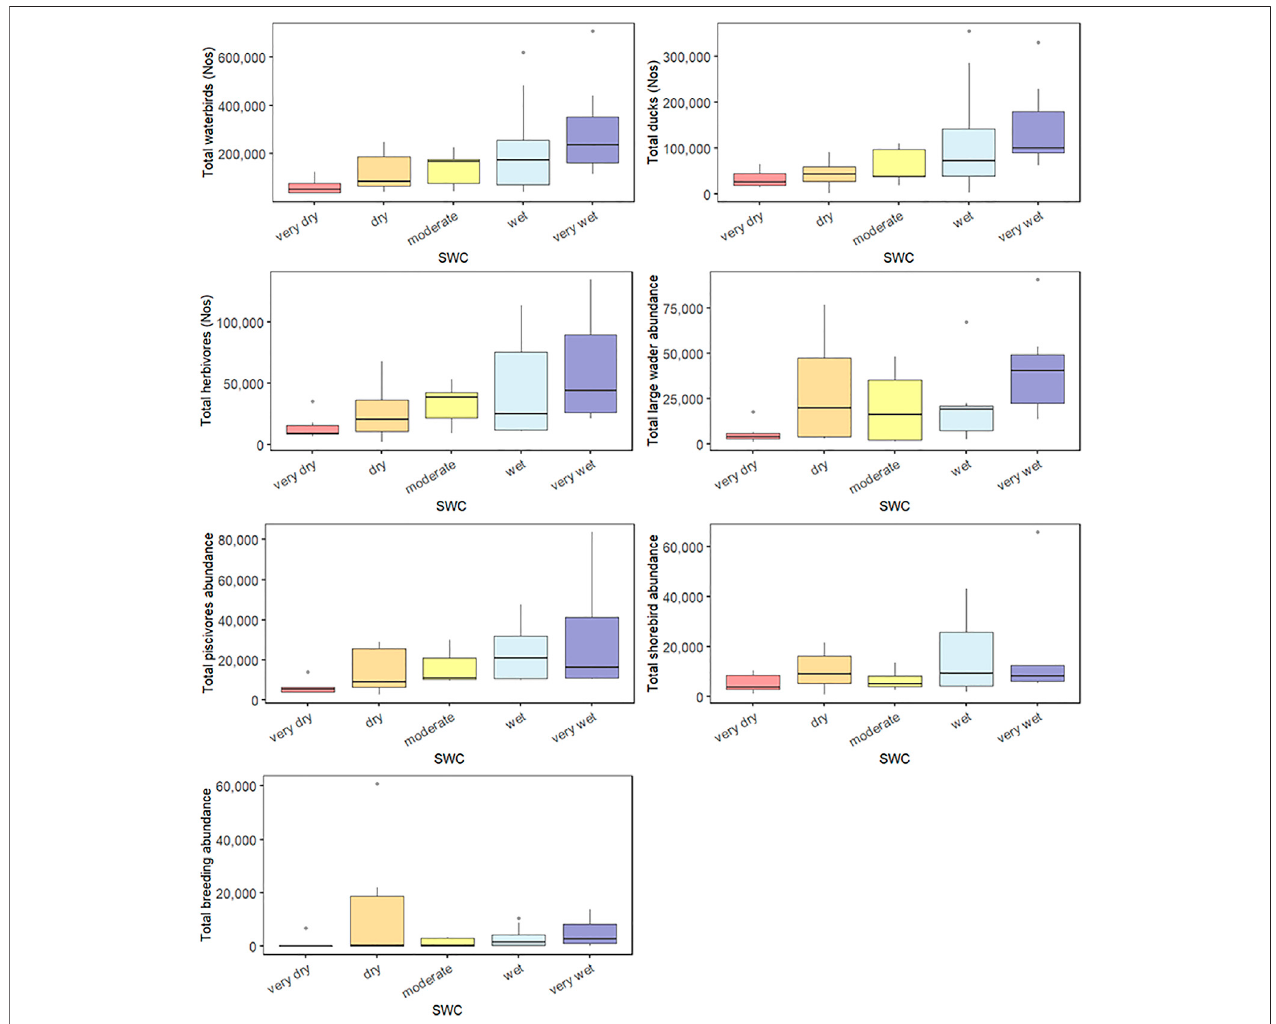
FIGURE3| Boxplotsofannual (1983 – 2020) waterbird abundance (total, fi vefunctionalresponse groups, and total breeding) from theEasternAustraliaWaterbird Surveys across the Murray-Darling Basin by fi ve Surface Water Conditions (SWC).